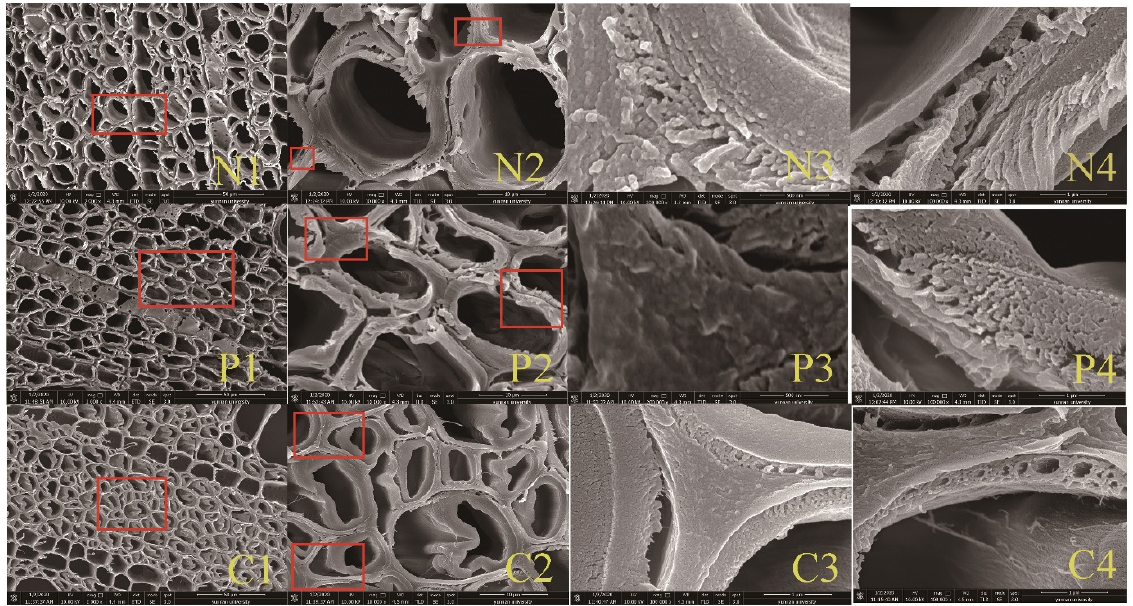
Figure 9. Scanning electron micrographs of cross sections cut from hemp hurd samples with no treatment (N1, N2, N3, and N4), exposed to pectinase for 30 (P1, P2, P3, and P4), or cellulase for 60 min (C1, C2, C3, and C4) and increasingly higher magnifications of the same fields.